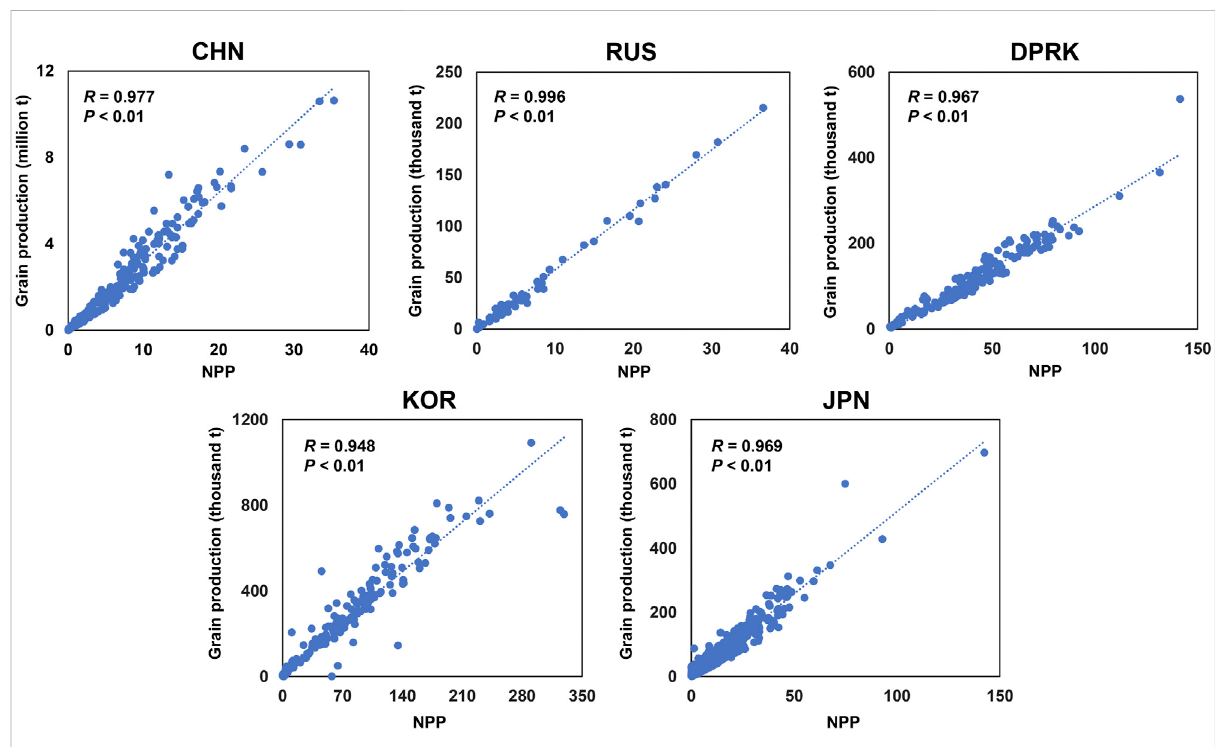
FIGURE 5 The correlation between NPP and grain production in the fi ve